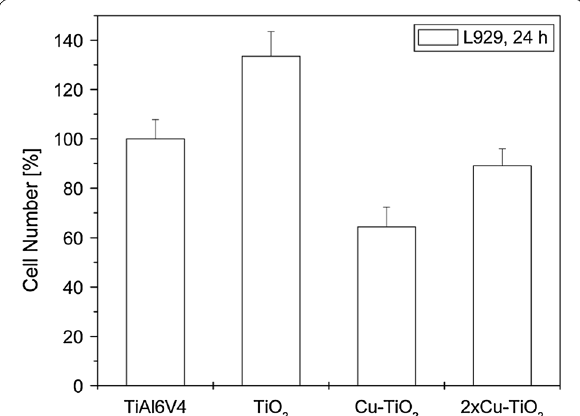
Fig. 4 Cell number of fibroblasts L929 on uncoated and the different TiO 2 -coated Ti6Al4V samples